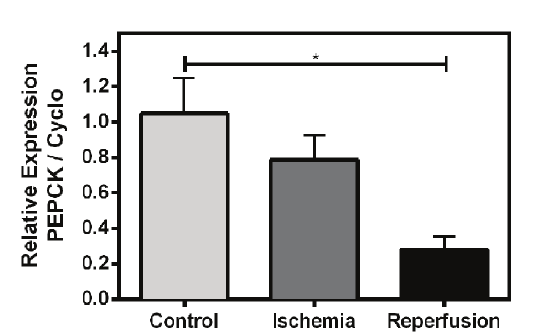
Figure 5 – The phosphoenolpyruvate carboxykinase is probably correlated with glycogen metabolism during ischemia and reperfusion. PEPCK transcription was significantly higher in control and ischemia groups. The statistical analysis